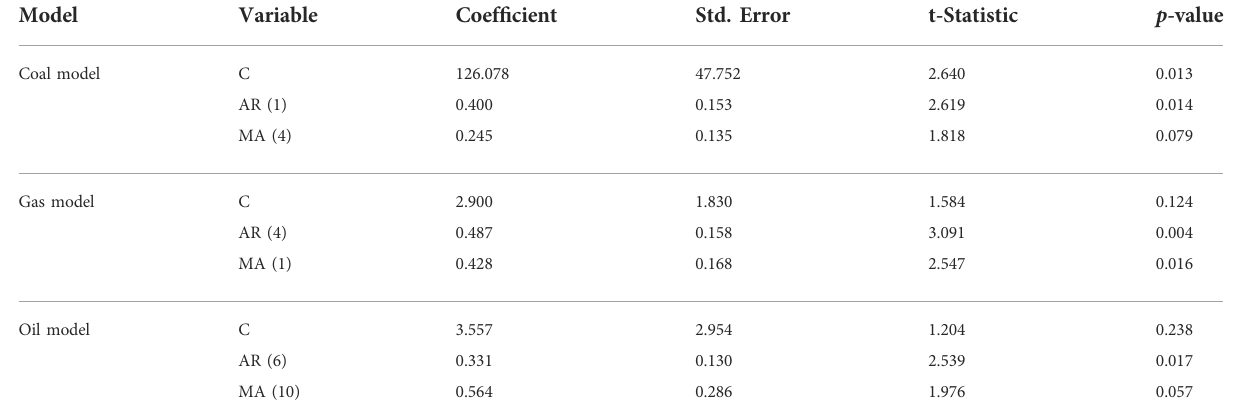
TABLE 5 Results for the ARIMA